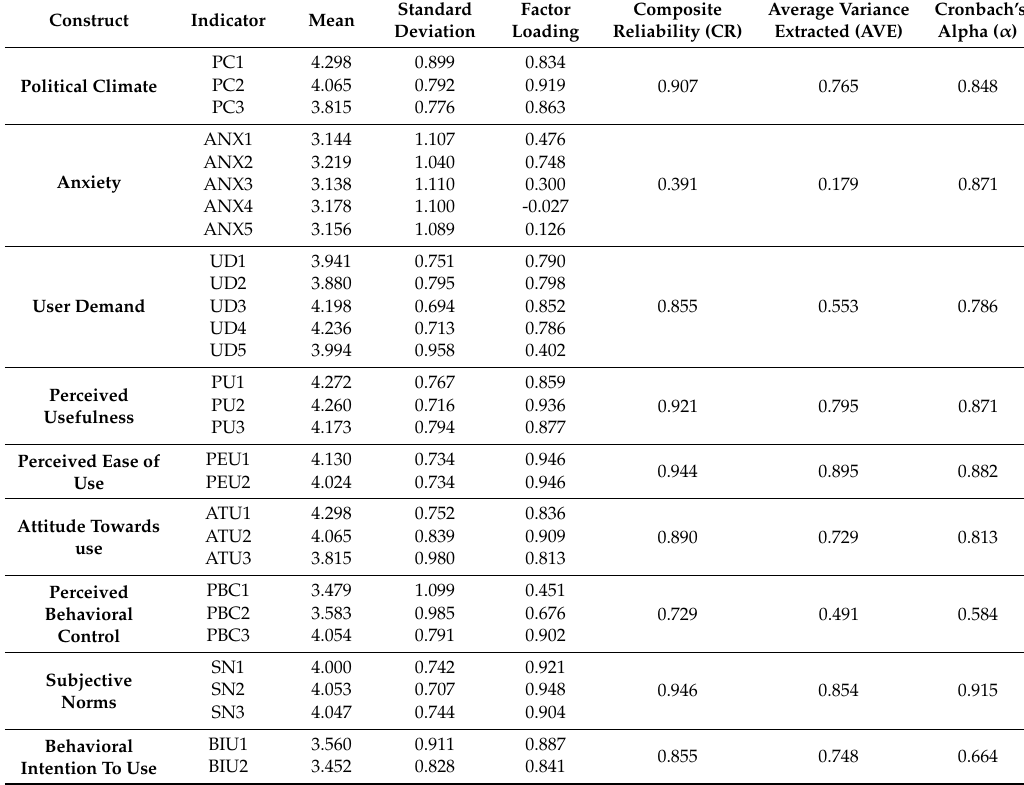
Table 10. Reliability and Convergent Validity Analysis (for eco-toilet system